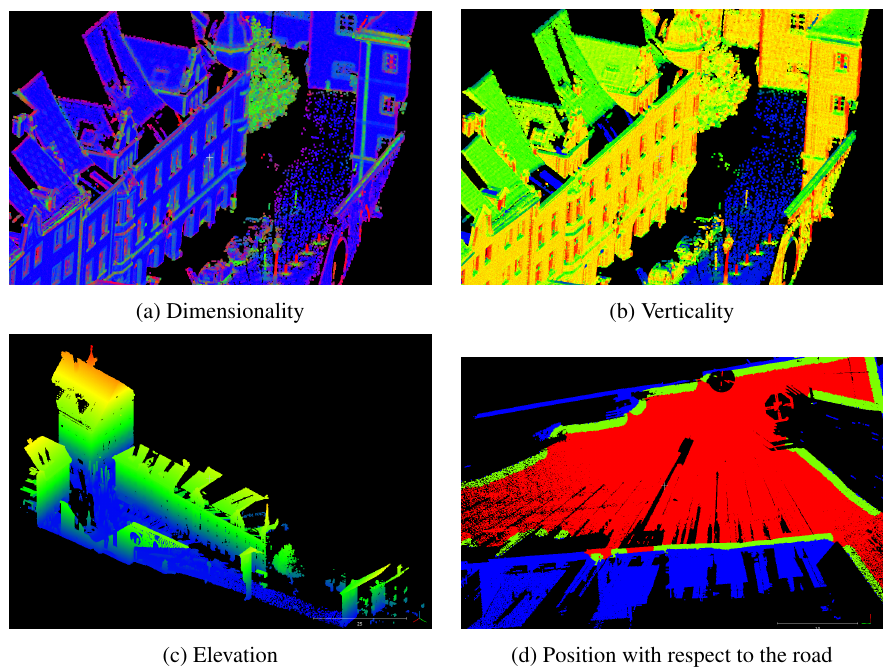
Figure 4. Representation of the four local geometric descriptors as well as the two global descriptors. In (a), the dimensionality vector [linearity, planarity, scattering] is color-coded by a proportional [red, green, blue] vector. In (b), the value of the verticality is represented with a color map going from blue (low verticality - roads) to green/yellow (average verticality - roofs and façades) to red (high verticality - poles). In (c), is represented the elevation with respect to the road. In (d), the position with respect to the road is represented with the following color-code: inside the road α -shape in red, bordering in green, and outside in blue. with δ ( · (cid:54) = 0) the function of R 4 : (cid:55)→ { 0 , 1 } equal to 0 in 0